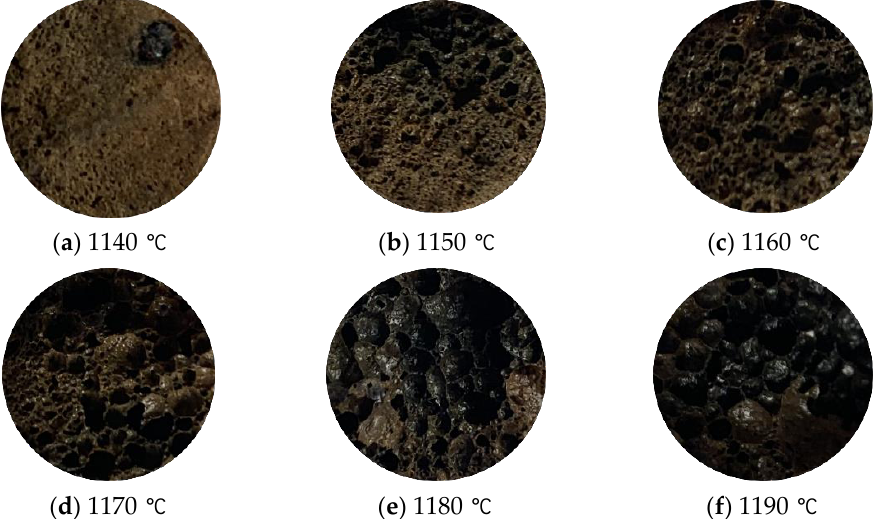
Figure 9. Cross-section of ceramsite at different sintering temperatures: ( a ) 1140 °C, ( b ) 1150 °C, ( c ) 1160 °C, ( d ) 1170 °C, ( e ) 1180 °C, ( f ) 1190 °C.